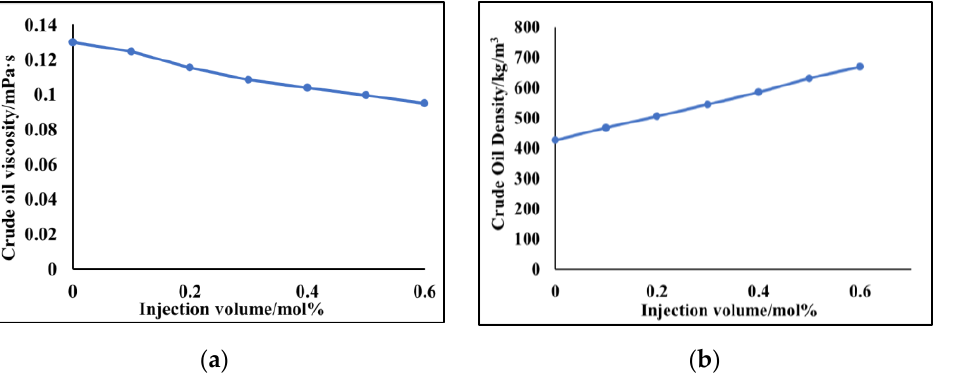
Figure 9. Relationship between saturation pressure and CO 2 injection molar quantity.